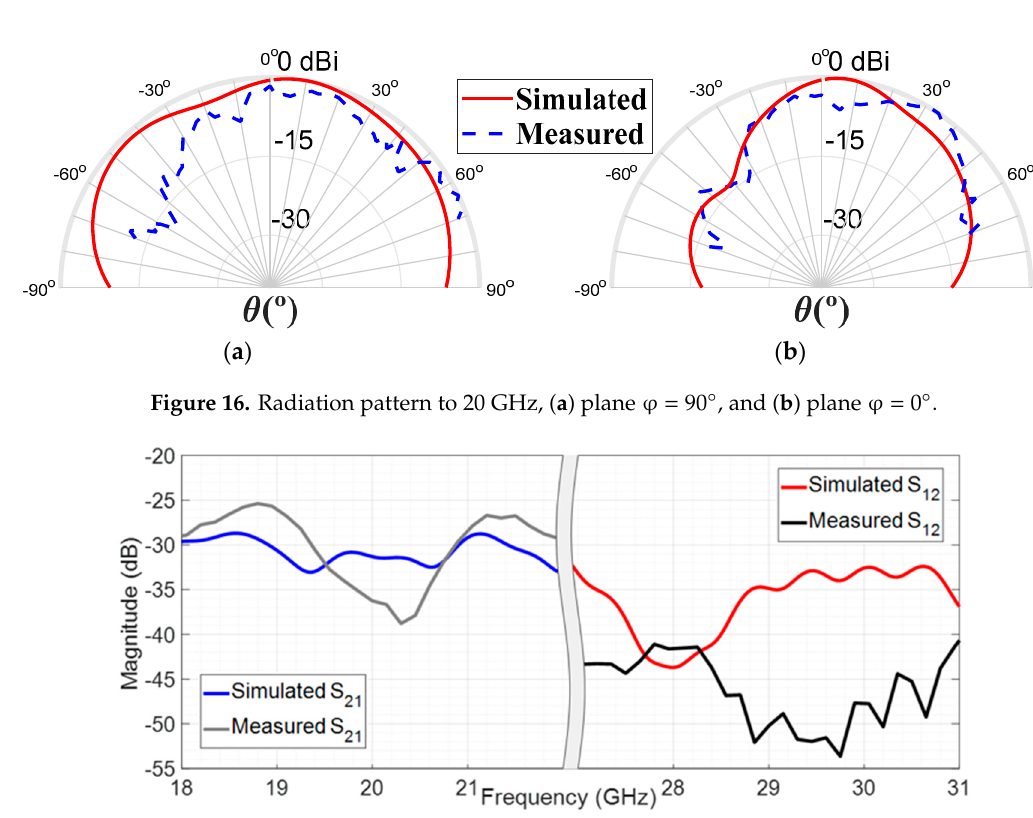
Figure 17. Simulated isolation between two ports.